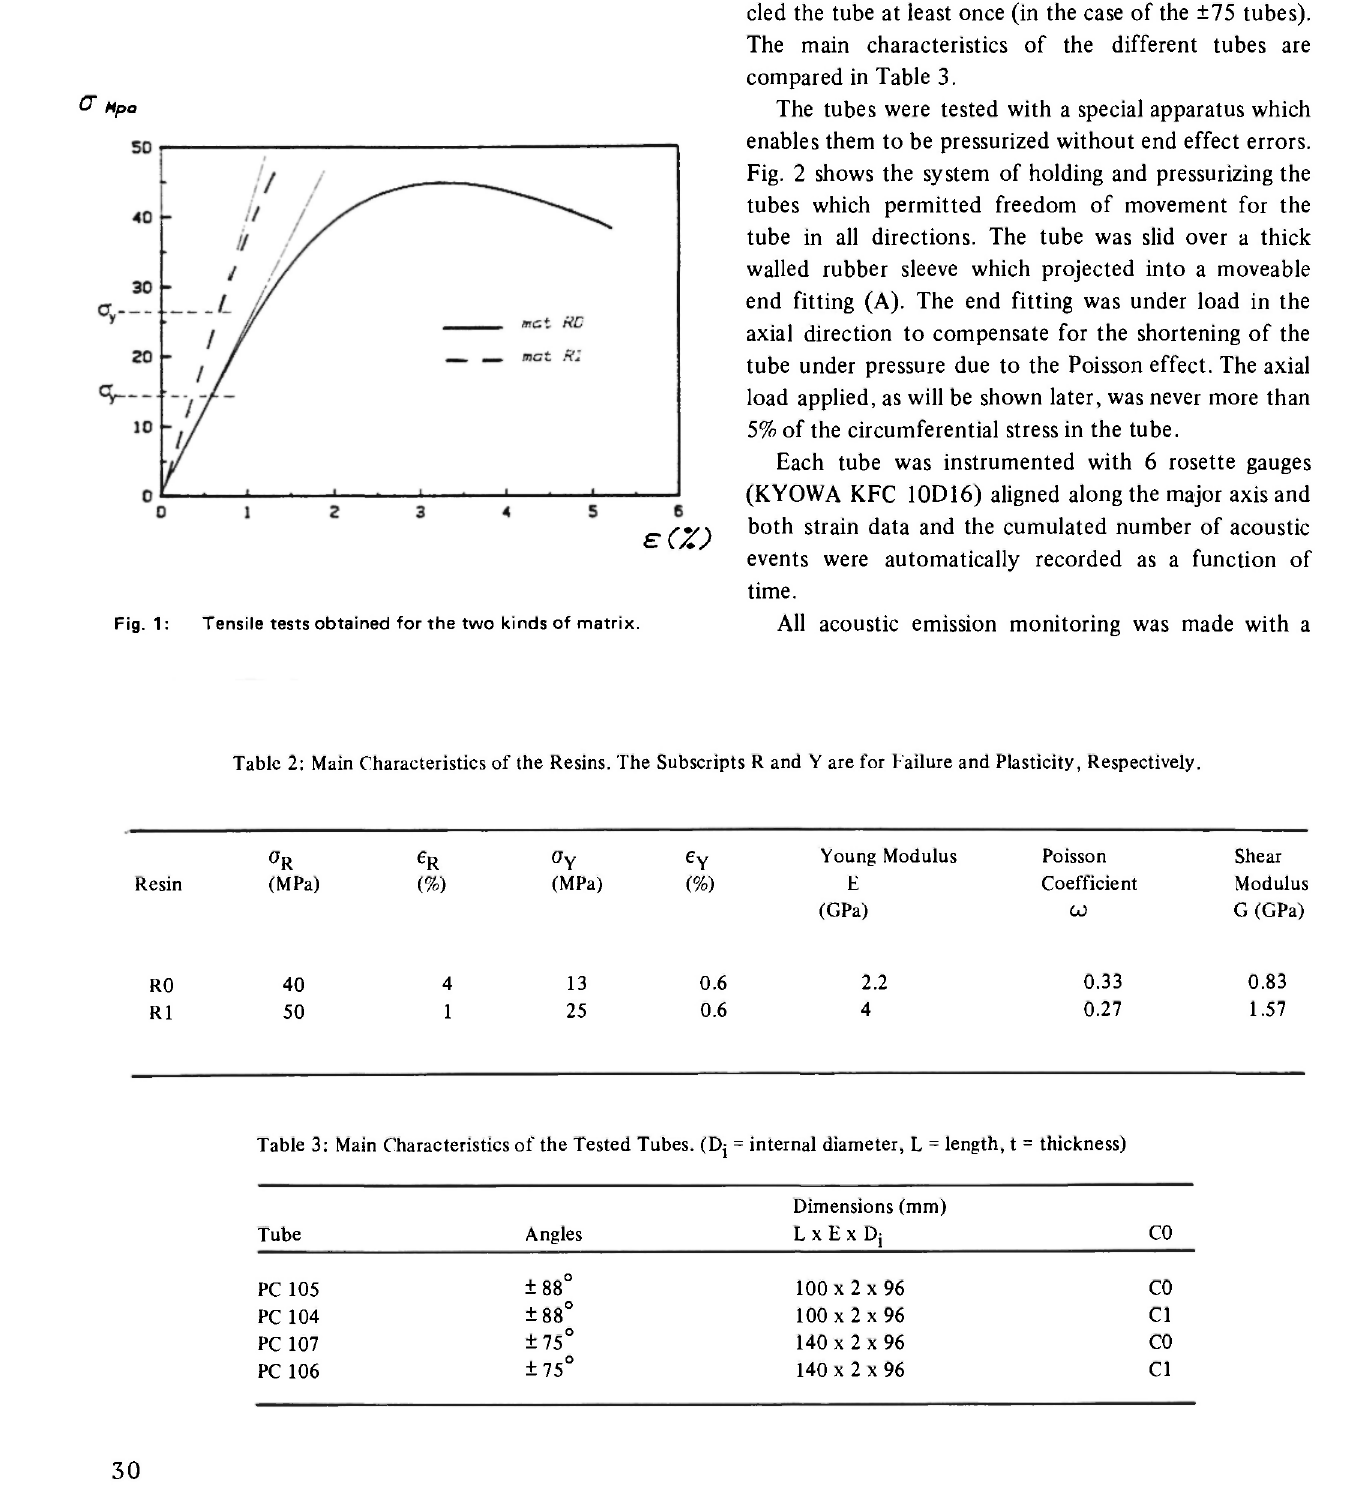
Fig. 1: Tensile tests obtained for the two kinds of matrix.